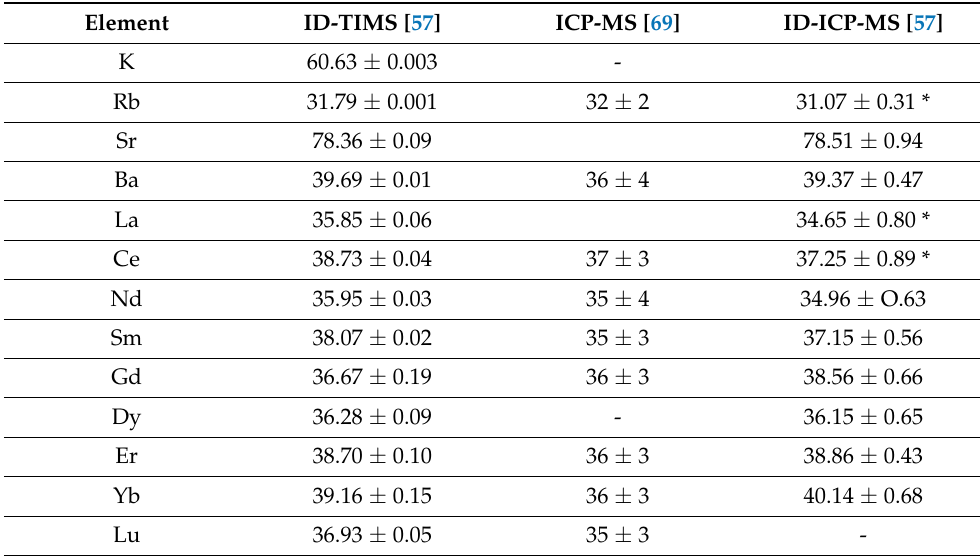
Table 6. Concentrations ( µ g/g) of some trace elements by ID-TIMS in NIST SRM 612 (trace elements in glass) in comparison with those obtained by ICP-MS.